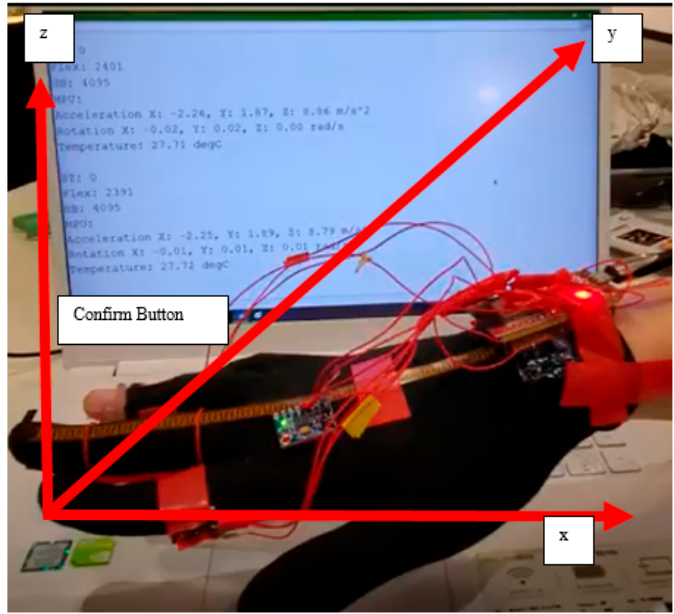
Figure 8. Real Demonstration of the glove’s application.